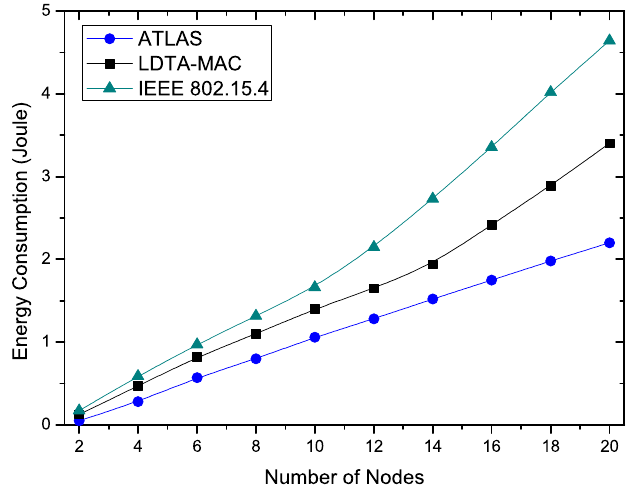
Figure 7. Average energy consumption over different number of nodes.